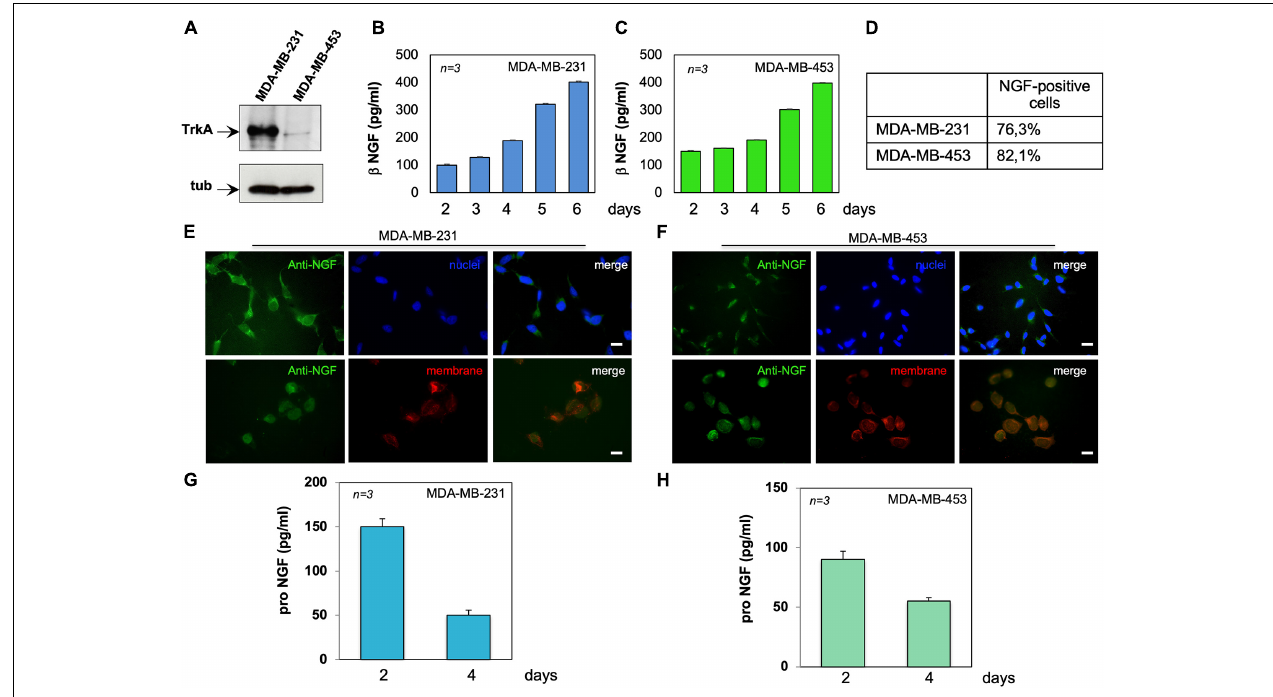
FIGURE 1 | MDA-MB-231 and MDA-MB-453 cells express tyrosine kinase A (TrkA) and release active neurotrophin β -nerve growth factor (NGF). (A) Lysates from the indicated cell lines were prepared and the lysate proteins analyzed by Western blotting (WB) using the antibodies against the indicated proteins. (B,C) MDA-MB-231 (B) and MDA-MB-453 (C) cells were made quiescent. Conditioned media (CM) were collected at the indicated times and the amount of β -NGF (in picograms per milliliter) was analyzed. Quiescent MDA-MB-231 and MDA-MB-453 cells on coverslips were stained for NGF. (D) Quantification of the cells positive for NGF immunostaining. (E,F) Representative immunofluorescence (IF) images from three different experiments (each in duplicate) were captured for MDA-MB-231 cells (E) and MDA-MB-453 (F) cells. For each experiment, at least 300 cells were scored. NGF ( green ), nuclei ( blue ), and the plasma membrane ( red ) were stained. Right panels show the merged images. Scale bar , 10 µ M. (G,H) CM from MDA-MB-231 (G) and MDA-MB-453 (H) cells were collected at the indicated times and the amount of pro-NGF (in picograms per milliliter) was analyzed by ELISA. Means and SEMs are shown. n represents the number of